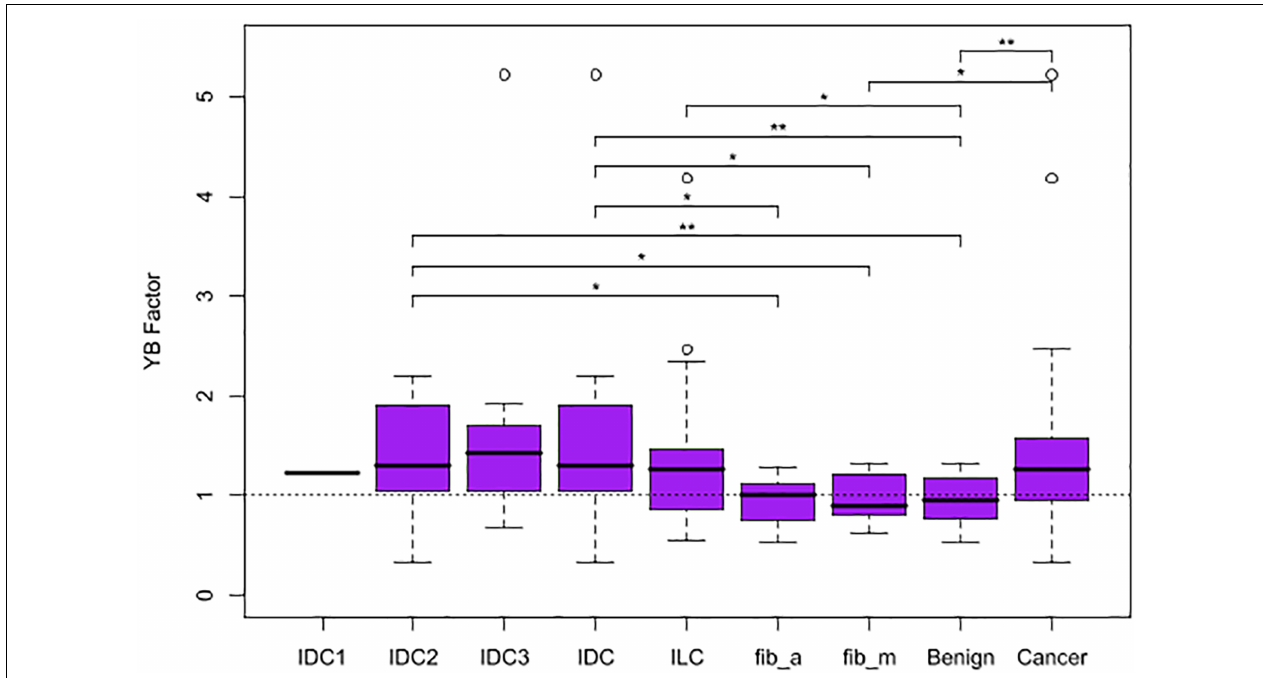
FIGURE 3 | Box plots representing the distribution of YB Factor for all subgroups of patient data. A horizontal dashed line is included at YB Factor = 1, an indicator of similarity between the tumorous and the opposite breast. One star represents p -value < 0.05 and two stars represent p -value <